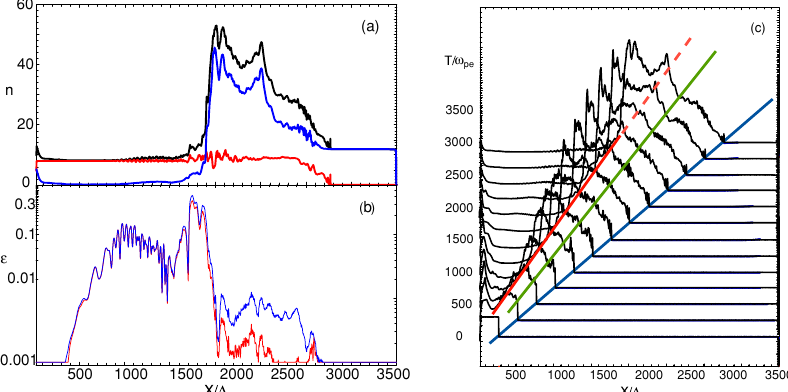
Figure 1. Averaged values of ( a ) the jet (red), the ambient (blue), and the total (black) electron density, and ( b ) electric (red) and magnetic (blue) field energy divided by the jet kinetic energy at t = 3250 ω − 1 pe . Panel ( c ) shows the evolution of the total electron density in time intervals of δ t = 250 ω − 1 pe . Diagonal lines indicate the motion of the jet front (blue: ≤ c ), the predicted contact discontinuity (CD) speed (green: ∼ 0.76 c ), and the trailing density jump (red: ∼ 0.56 c ). Adapted from Figure 1 in Figure 1. Averaged values of (a) jet (red), ambient (blue), and total (black) electron density, and (b) electric (red) and magnetic (blue) field energy divided by the jet kinetic energy at t = 3250 ω − 1 pe . Panel (c) shows the evolution of the totalelectrondensityintimeintervalsof δt = 250 ω − 1 pe .Diagonallinesindicate motion of the jet front (blue: (cid:2) c ), predicted CD speed (green: ∼ 0 . 76 c ), and trailing density jump (red: ∼ 0 . 56 c ). are similar to electron profiles. Ambient particles become swept up after jet electrons pass x/ Δ ∼ 500. By t = 3250 ω − 1 pe , the density has evolved into a two-step plateau behind the jet front. The maximum density in this shocked region is about three timestheinitialambientdensity.Thejet-particledensityremains nearly constant up to near the jet front. Current filaments and strong electromagnetic fields accom- pany growth of the Weibel instability in the trailing shock re- gion. The electromagnetic fields are about four times larger than that seen previously using a much shorter grid system ( L x = 640 Δ ). At t = 3250 ω − 1 pe , the electromagnetic fields are largest at x/ Δ ∼ 1700, and decline by about one order of mag- nitude beyond x/ Δ = 2300 in the shocked region (Nishikawa et al. 2006; Ramirez-Ruiz et al. 2007).